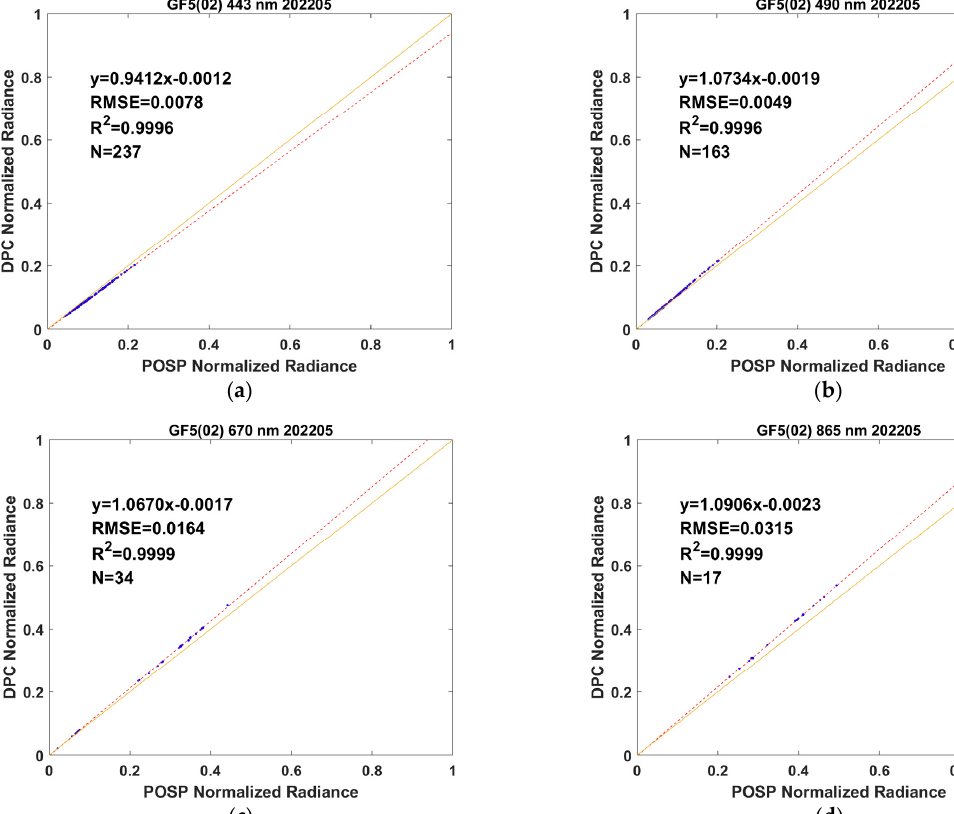
Figure 5. The linear fitting coefficients of DPC and POSP normalized radiance in common spectral bands at nadir. The data pairs are a collection selected from May 2022 of ( a ) 443 nm; ( b ) 490 nm; ( c ) 670 nm; and ( d ) 865 nm bands in DPC and POSP Level 1 products. Yellow solid and red dashed lines are the 1:1 lines and fit lines, respectively. The reason for the fewer matching data points is that the amount of raw data points at nadir is small.